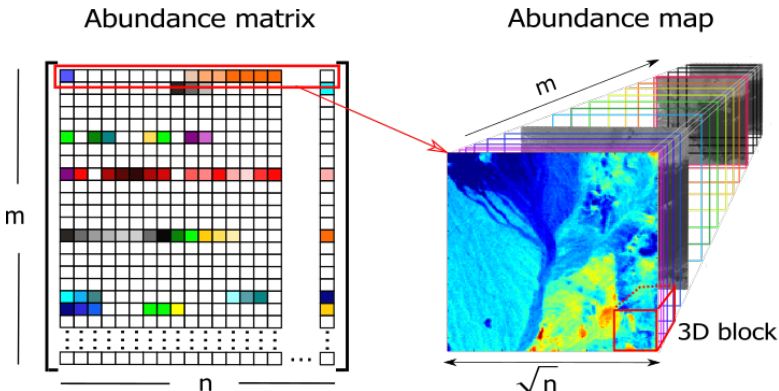
Figure 2. Illustration of endmember ( m ) direction in abundance dimension. 3D local block moves through pixels ( n ) as well as m direction of abundance